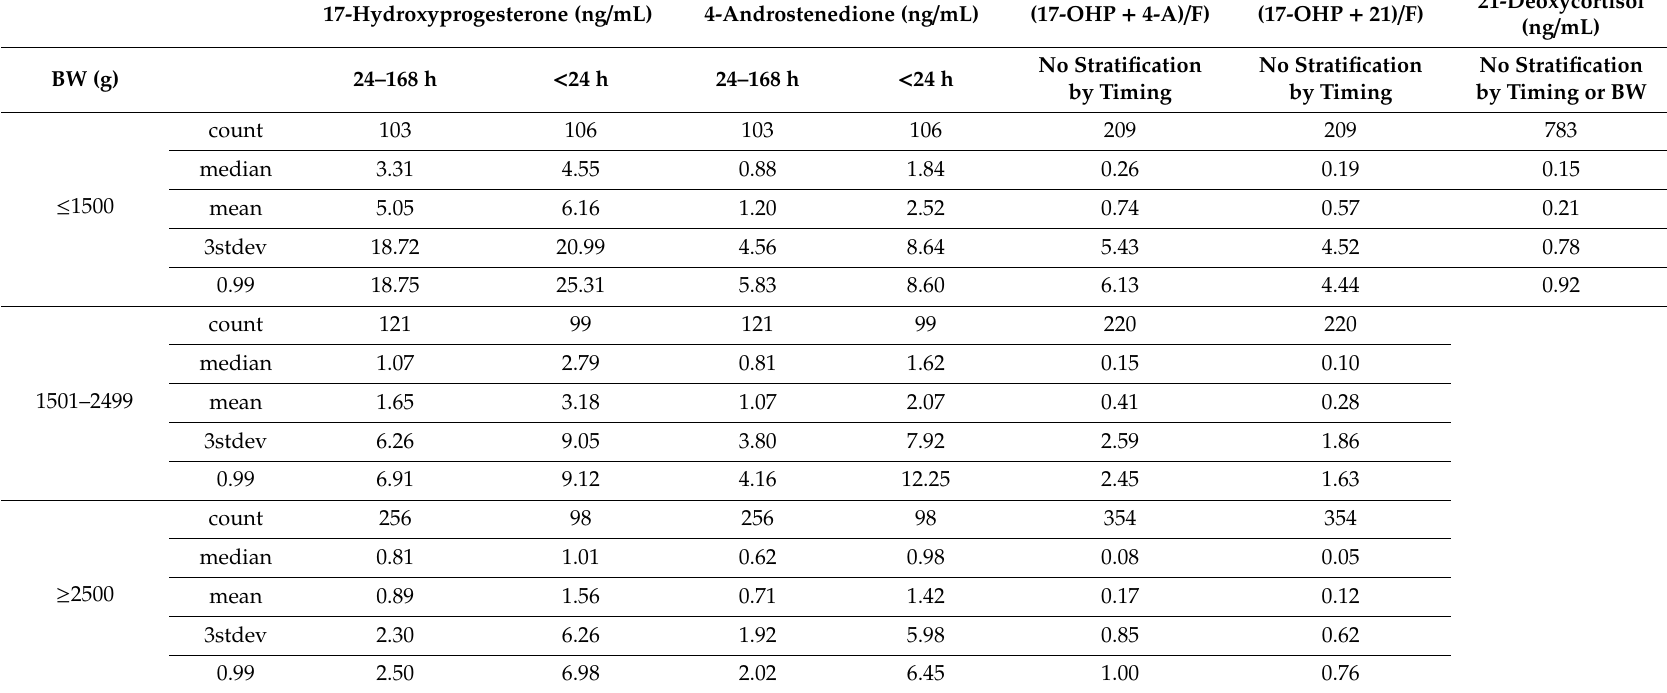
Table 3. Distribution of steroid concentrations within the normal population. Table 3 provides the concentrations for each steroid (17OHP, 4-A, 21) and both ratios within the normal population. The median, mean, 3 standard deviation (3stdev), and 99th percentile (0.99) values are provided. The normal population is stratified by birth weight and time of collection. In situations where there was no statistical di ff erence between the stratified groups, the data is combined. BW = birth